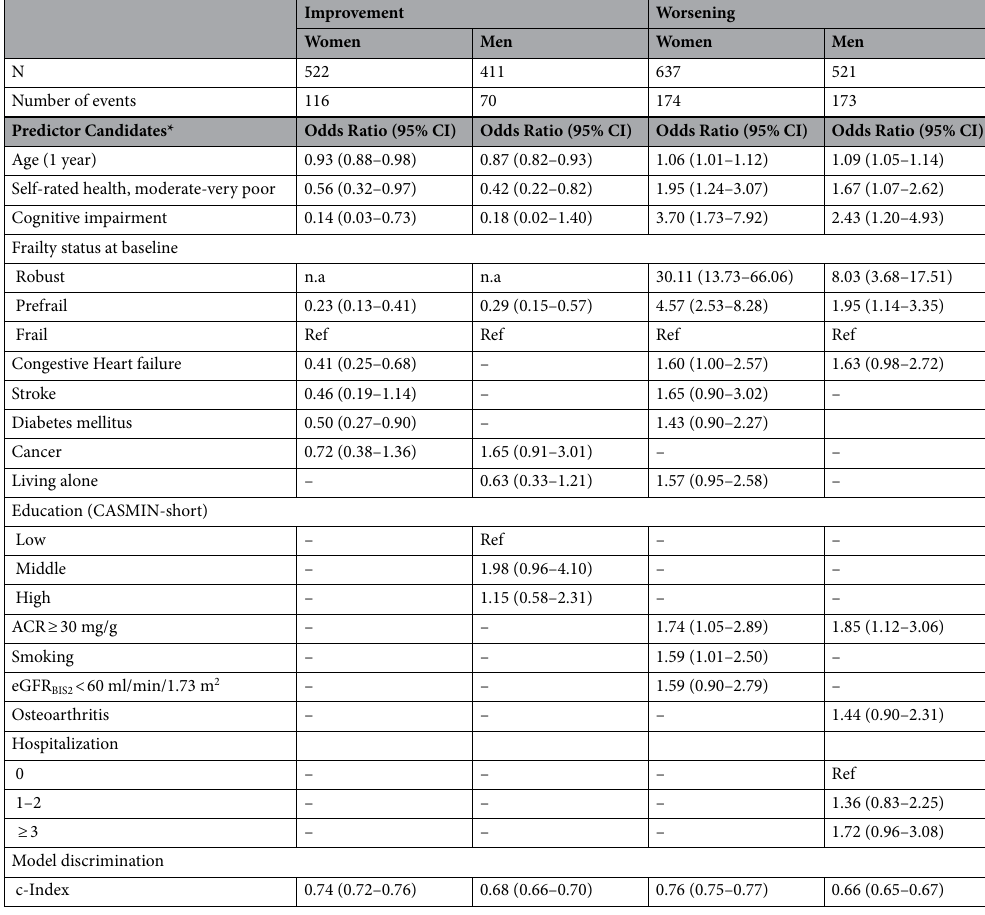
Table 3. Prognostic prediction models for frailty improvement or worsening after 2.1 years in community- dwelling older adults stratified for gender. *Predictor Candidates not included in any model: BMI, Polypharmacy,